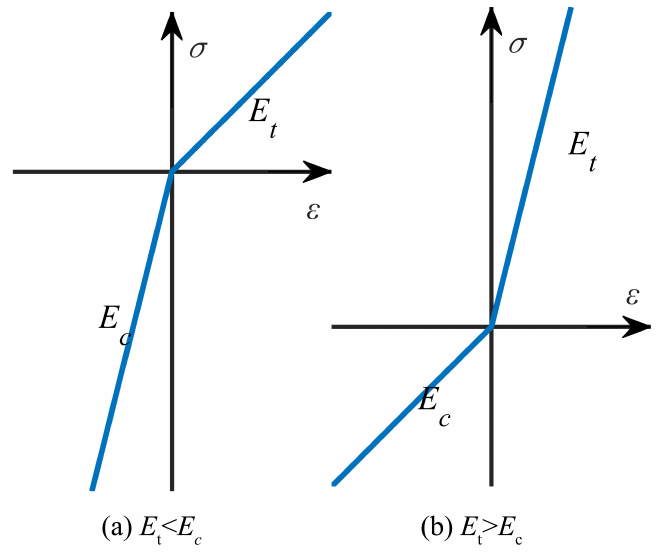
Figure 3. Dual modulus stress–strain relation ( a ) E t < E c , ( b ) E t > E c